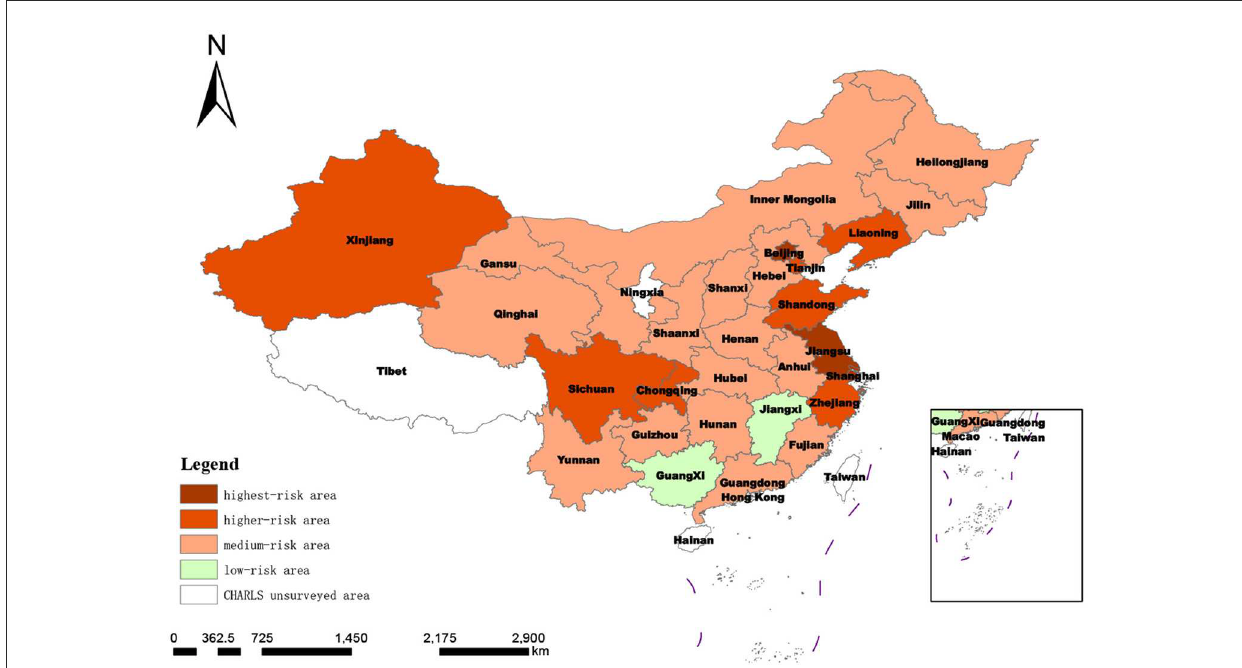
FIGURE2 Spatial distribution of degree of regional social disability risk based on target-layer score.